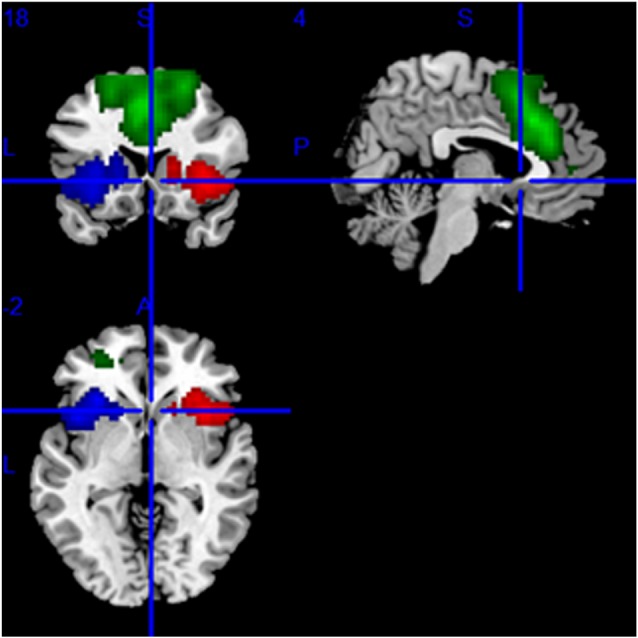
The mask of the SN, mainly including the bilateral frontoinsular cortex (FIC) and anterior cingulate cortex (ACC). The red area is the right, the blue area is the left FIC, and the green area is ACC.